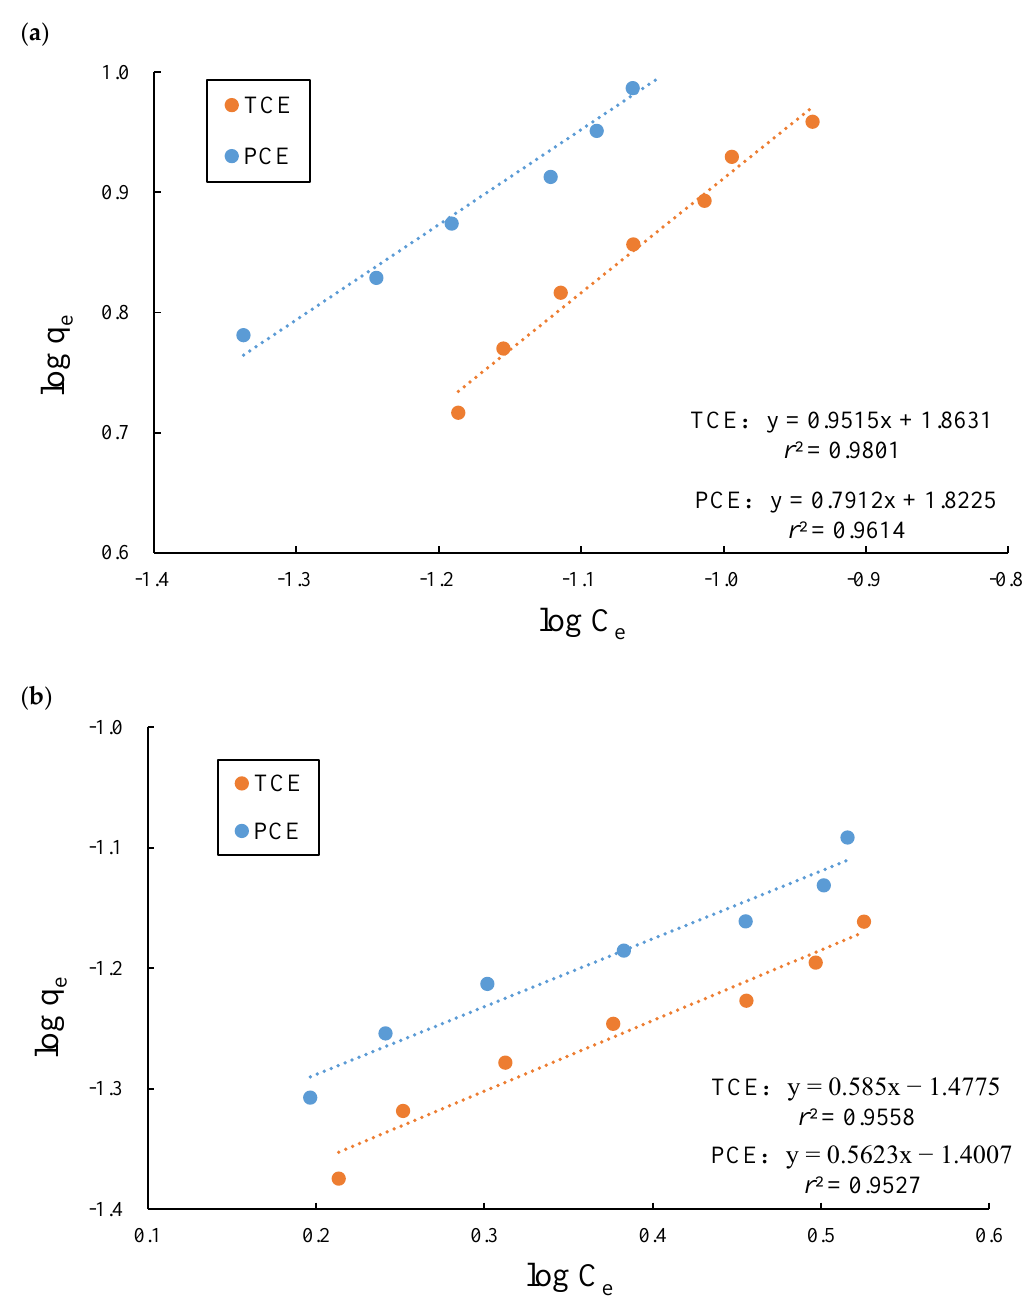
Figure 7. Experimental data of ( a ) activated carbon and ( b ) silica gel adsorption onto TCE and PCE fitted to linearized forms of Freundlich isotherms. Table 9. Adsorption parameters of Freundlich and Langmuir isotherm models.